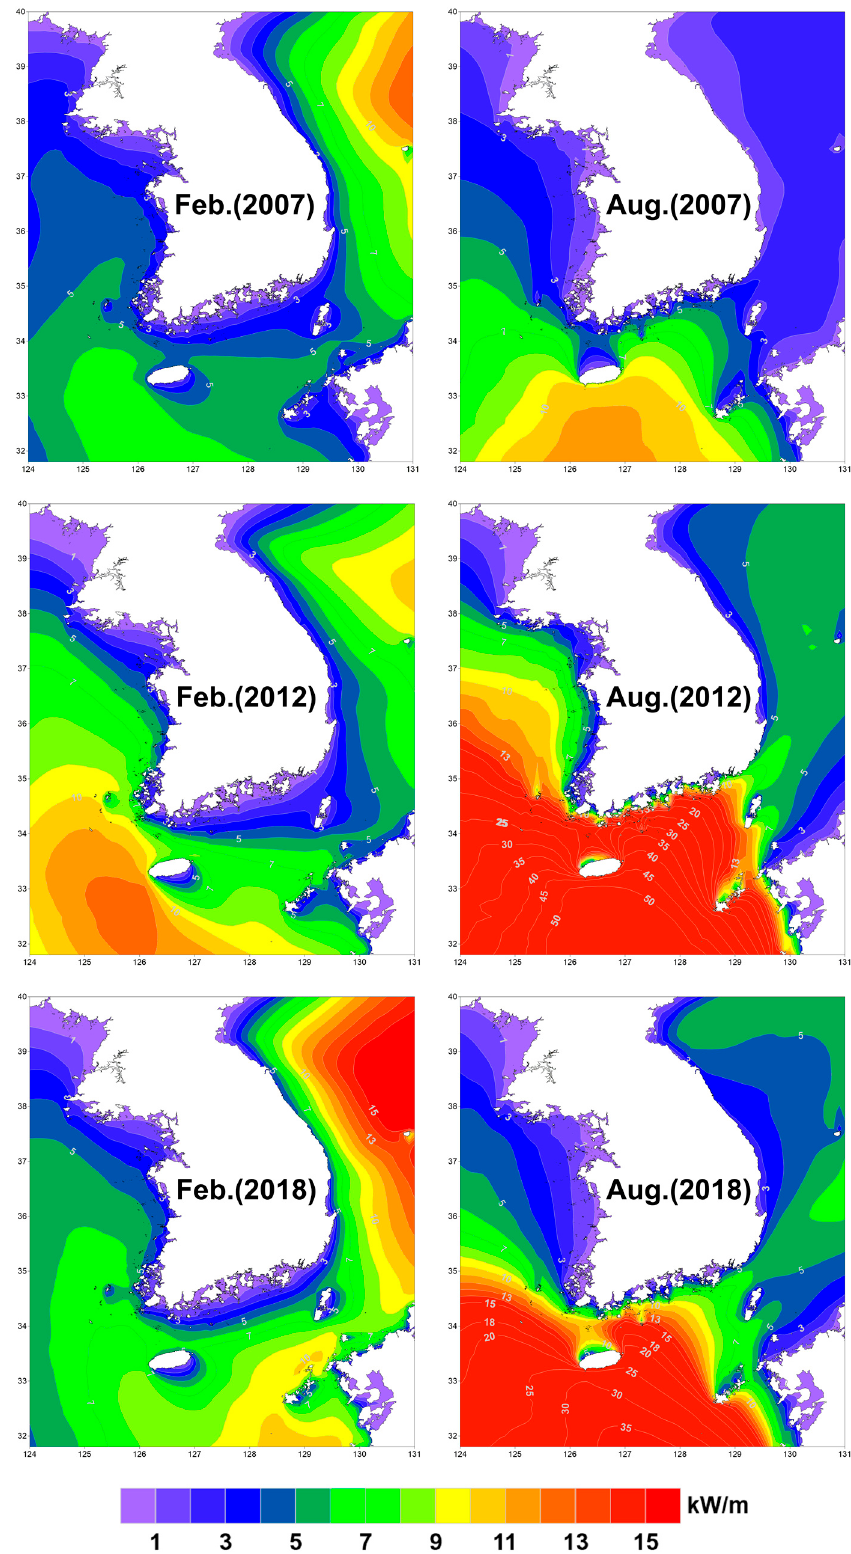
Figure 13. Monthly averaged wave power of February and August around the Korean Peninsula in 2007, 2012, and 2018.